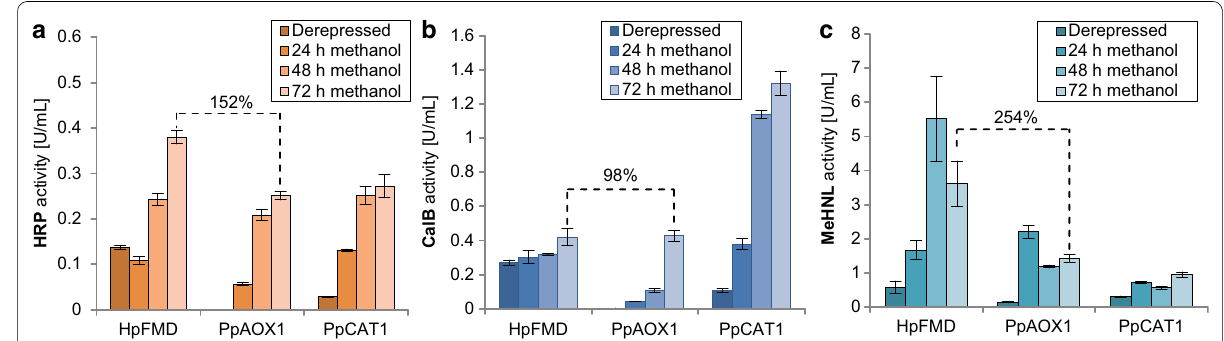
Fig. 3 Applying the HpFMD promoter for expression of the enzymes HRP ( a ), CalB ( b ) and MeHNL ( c ) confirms the high expression observed with eGFP (Fig. 1). The strains were grown in DWPs on BMD1 media until glucose depletion for 60 h and were subsequently induced with methanol. HRP and CalB activities in the supernatants were measured and cells lysed to measure intracellular MeHNL activity. Mean values (MVs) and standard deviation (SDs) of biological quadruplicates are shown. The activities of the methanol induced HpFMD promoter compared to the state of the art AOX1 promoter are highlighted (after 72 h of methanol